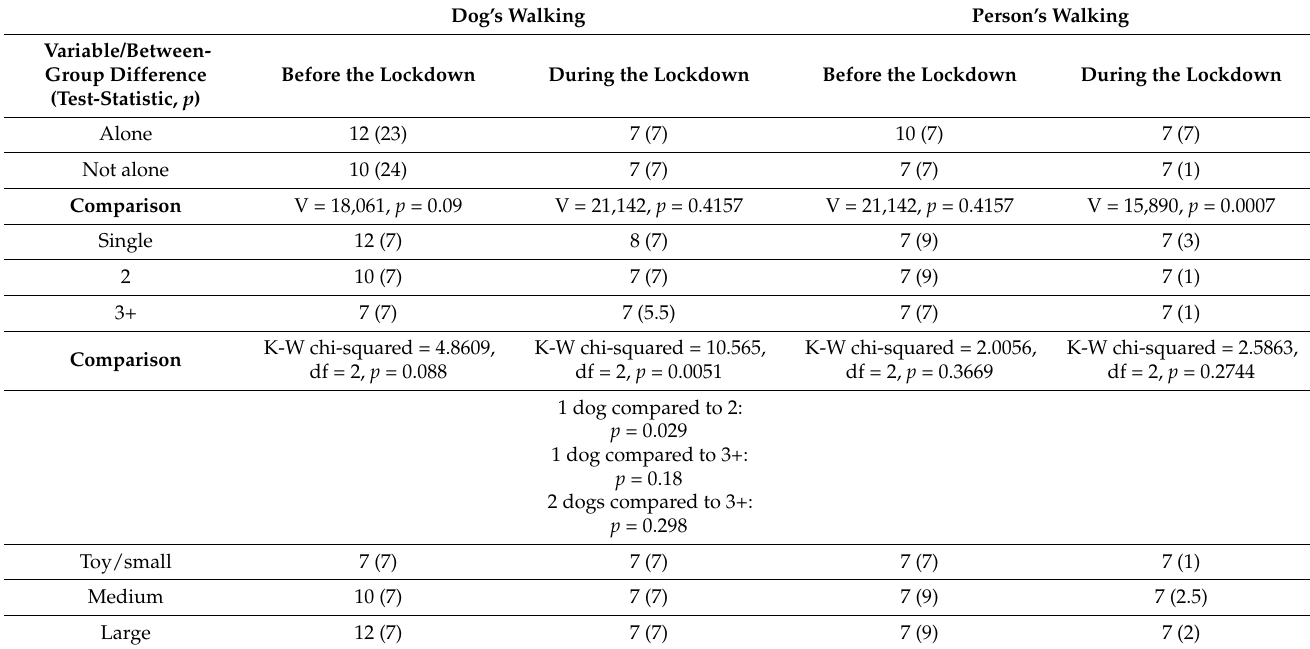
Table 2. Between-group differences in frequency of dog’s and person’s walks per week both before and during the lockdown are summarised with Mann-Whitney test-statistics where 2 categories were compared (V), K-W test-statistic (X 2 ) where 3 or more categories were compared and test significance levels ( p ). Where the between-group comparison was statistically significant ( p < 0.05), Dunn p values with further Benjamini–Hochberg FDR adjustment for multiple comparisons are